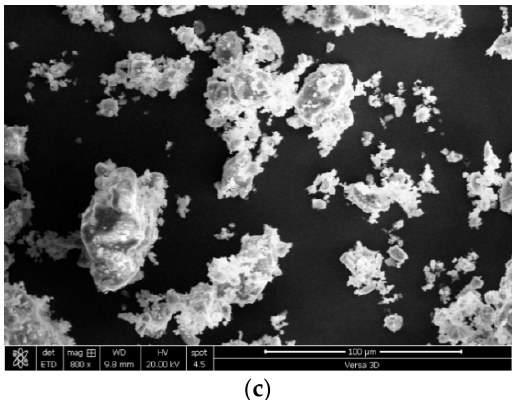
Figure 2. Scanning electron microscopy (SEM) images of fine materials. ( a ) Ultrafine (C); ( b ) Silica fume (S); ( c ) Cement.